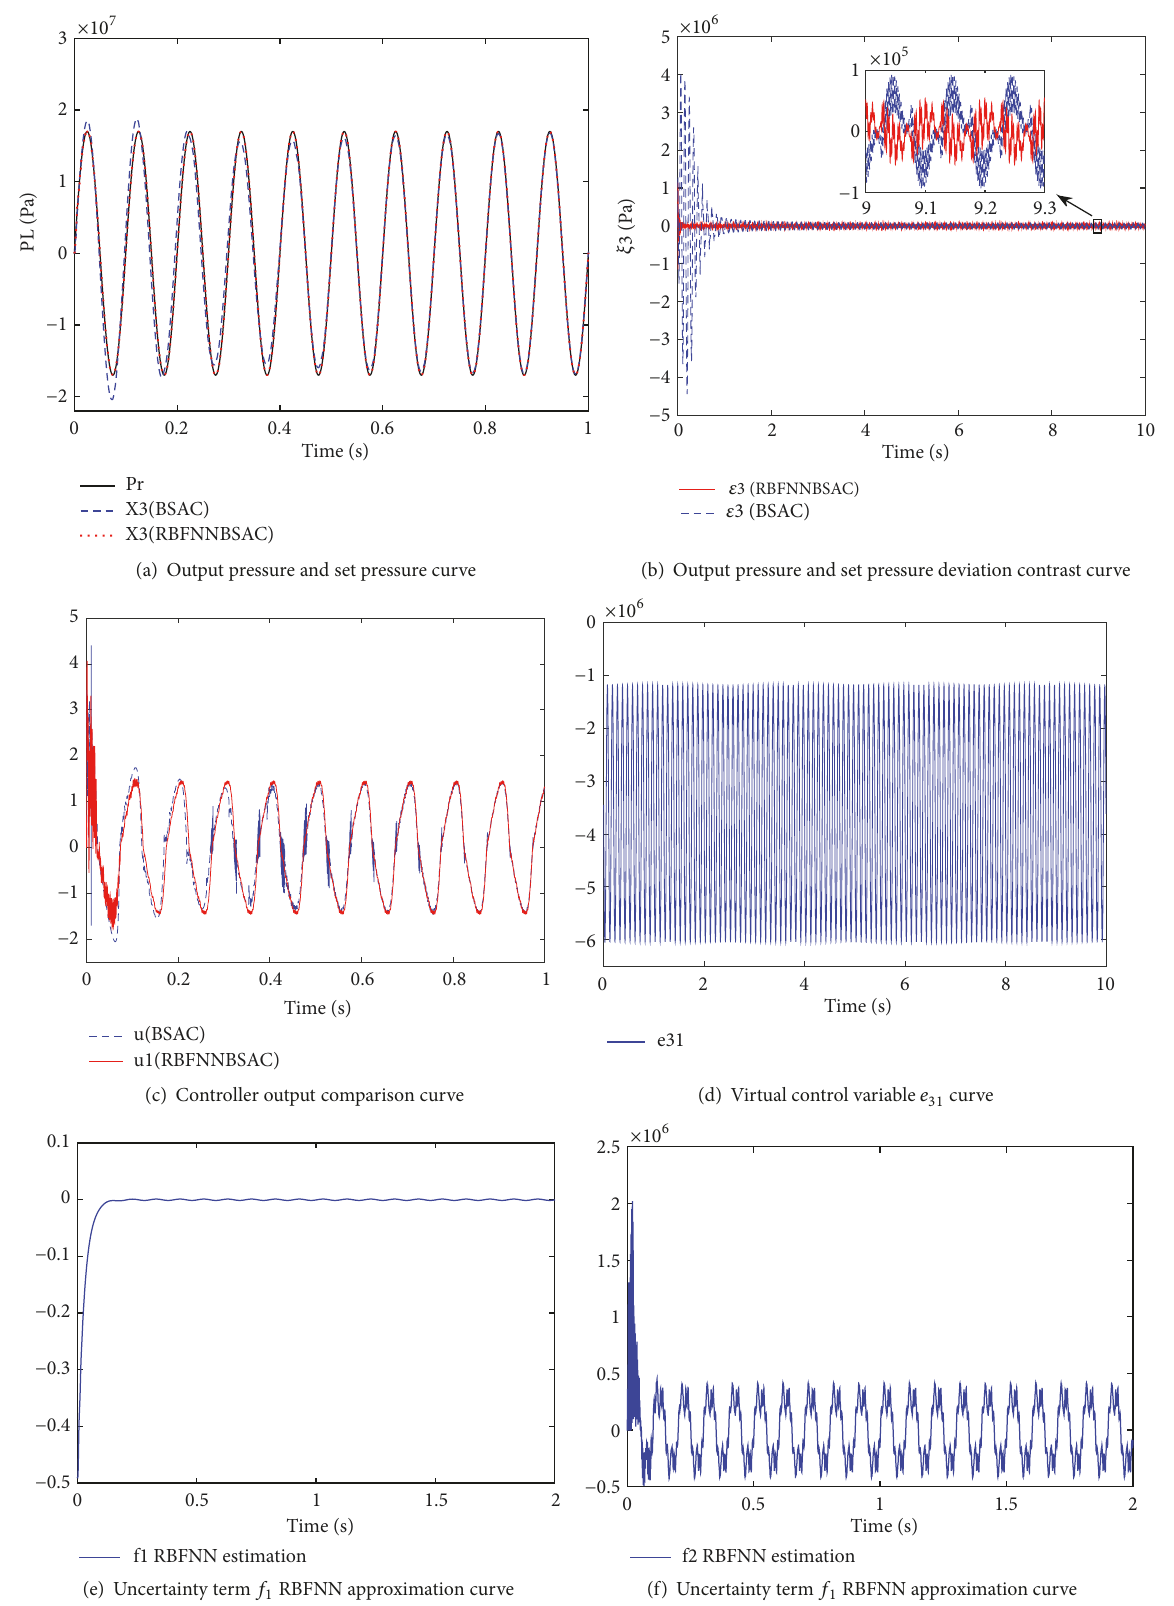
Figure 5: Performance curve of dynamic pressure cylinder AMESim model RBF neural network backstepping sliding mode adaptive control (10Hz